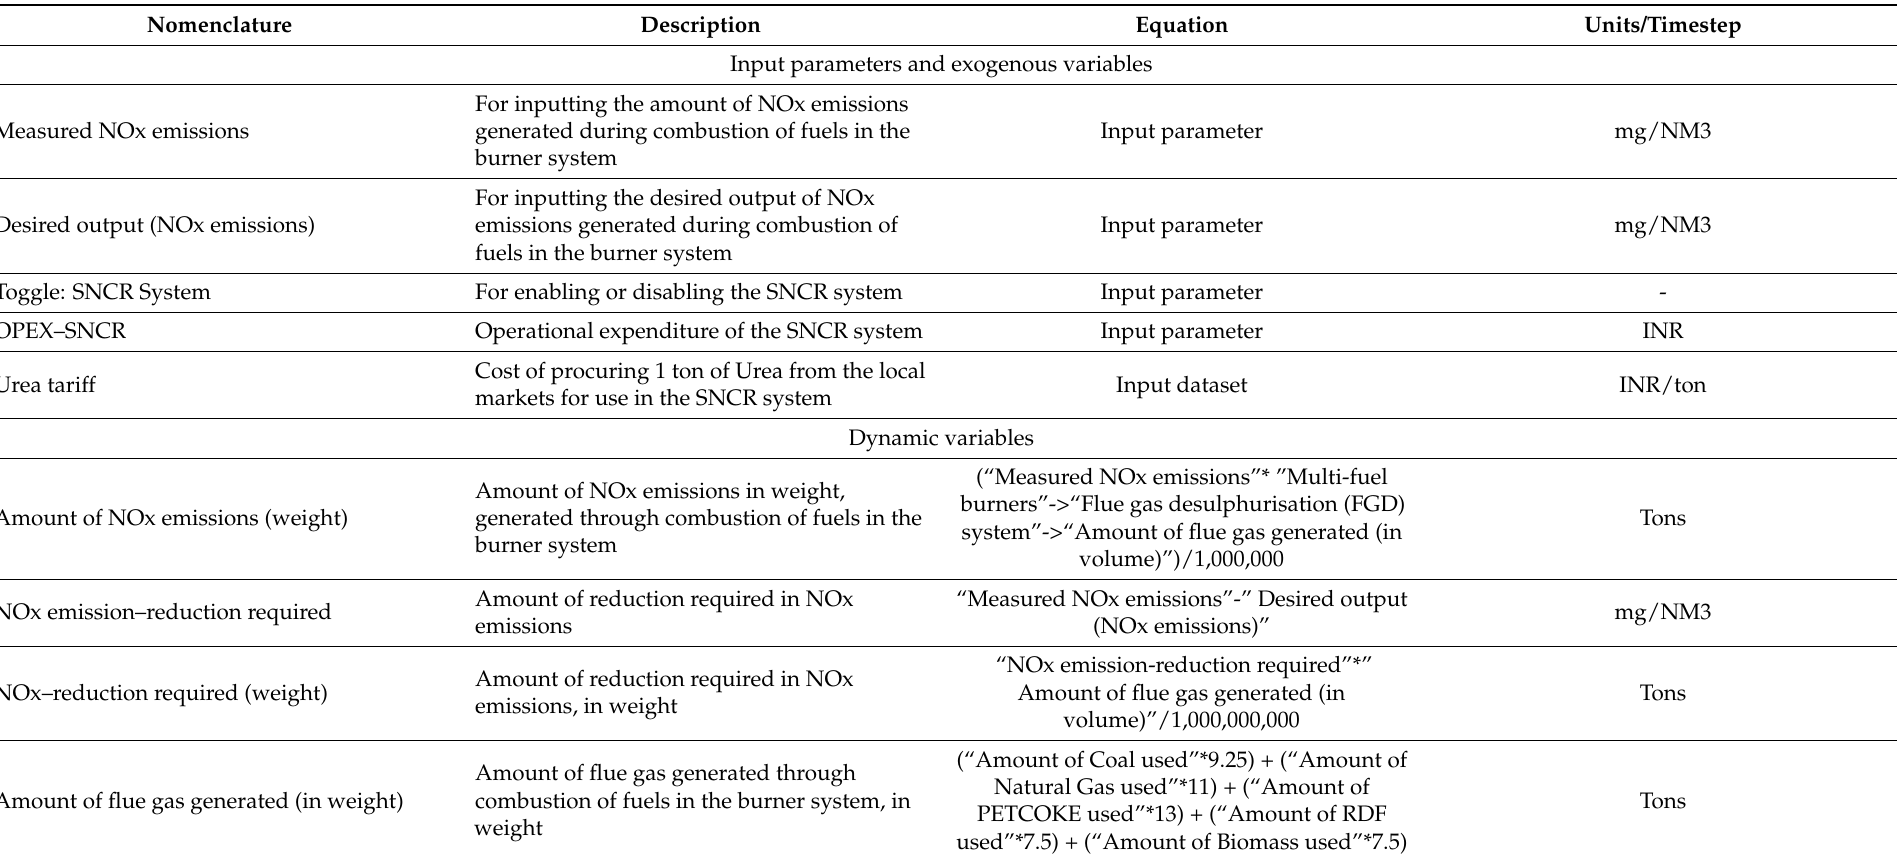
Table A3. Description of the variables used in the SNCR